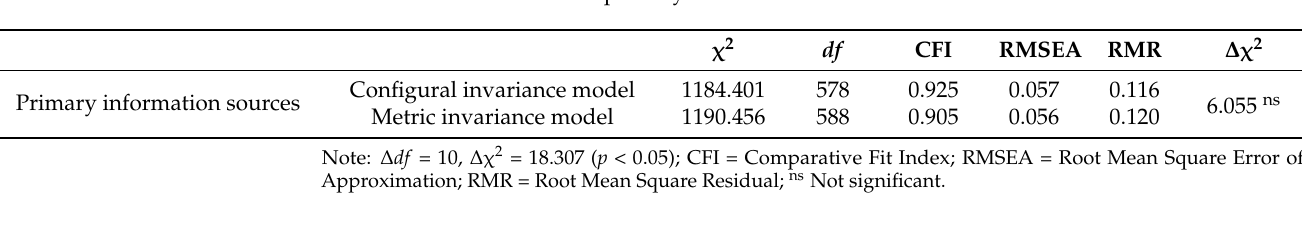
Table 5. Model fit indices of primary information sources.